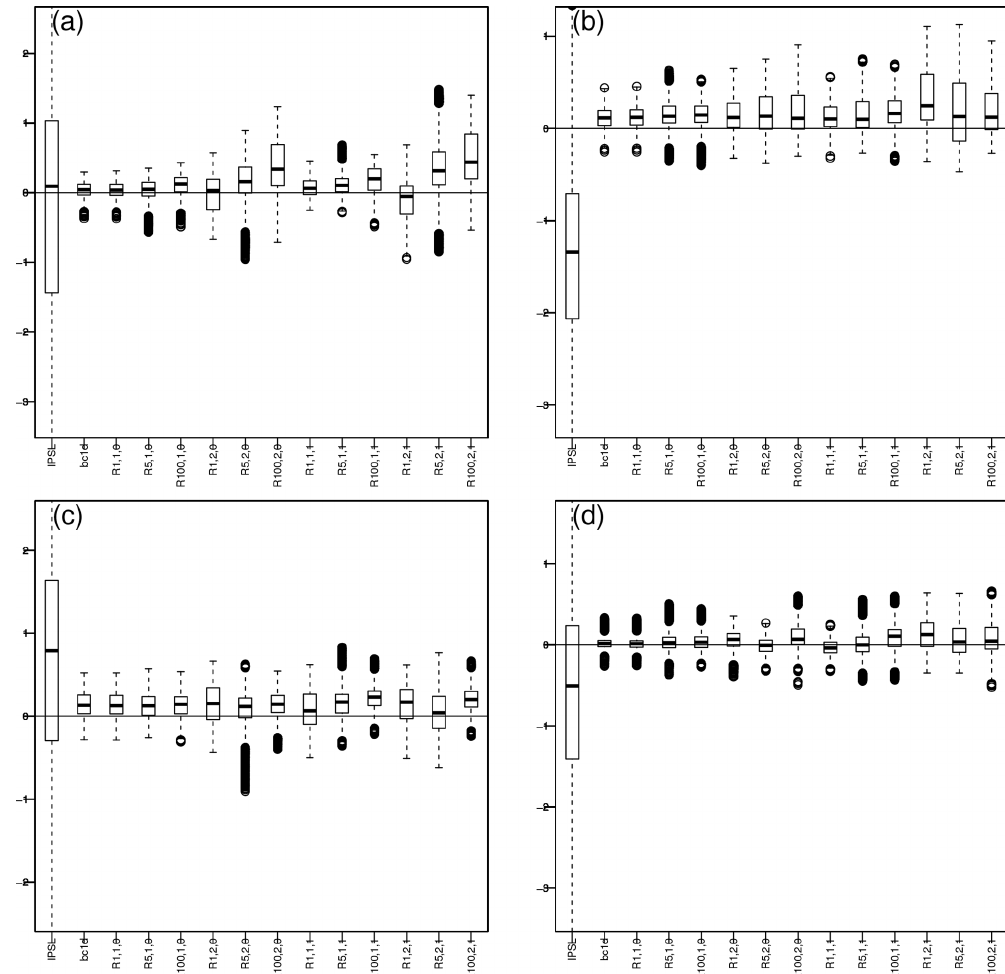
Figure 6. Boxplots of differences in mean temperature per grid point with respect to WFDEI, i.e., mean(model or BC) minus mean(WFDEI): (a) winter, (b) spring, (c) summer and (d) fall. The associated maps are given in Figs.